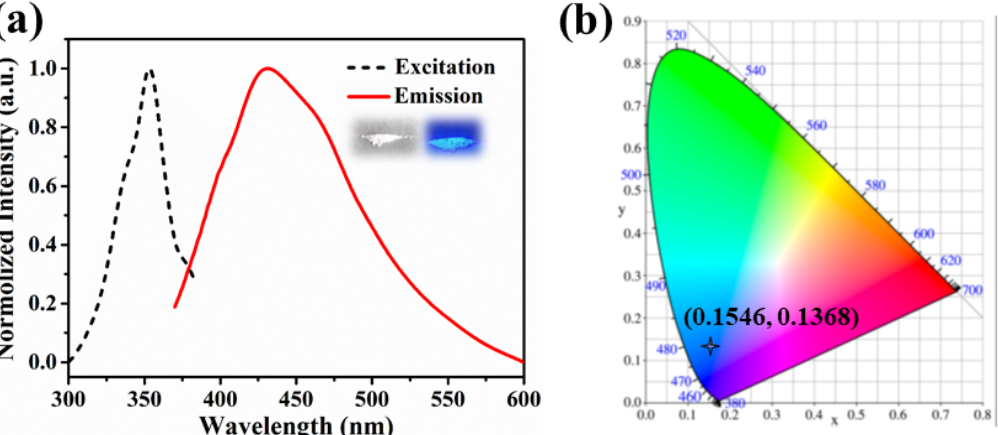
Figure 3. Excitation and emission spectra of CdBPTC, the insert shows samples under sunlight (left) and the ultraviolet light at 365 nm (right) ( a ), and the corresponding CIE chromaticity diagram showing the luminescence colors of CdBPTC ( b